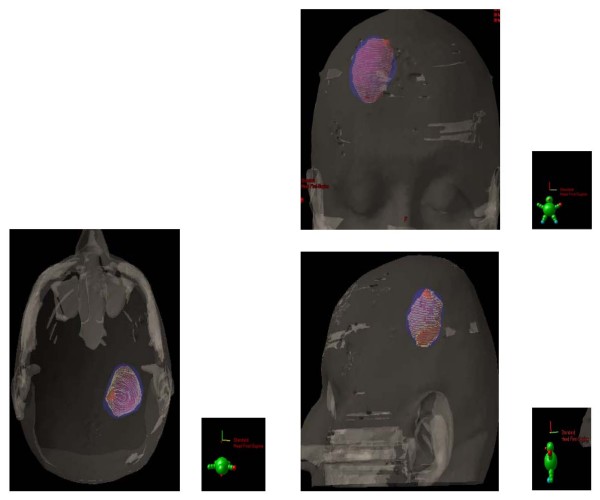
Biological (BTV, blue) and morphological gross tumour (GTV, red) volume defining the clinical target volume in 19 patients with high-grade glioma. Note the common volume between the tumour volumes (yellow chicken wire). Good BTV-GTV matching is shown in 1 patient.